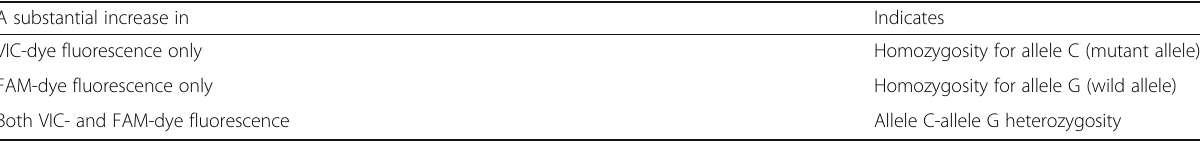
Table 1 Relation between fluorescence signals and sequences in a sample A substantial increase in Indicates VIC-dye fluorescence only FAM-dye fluorescence only Both VIC- and FAM-dye